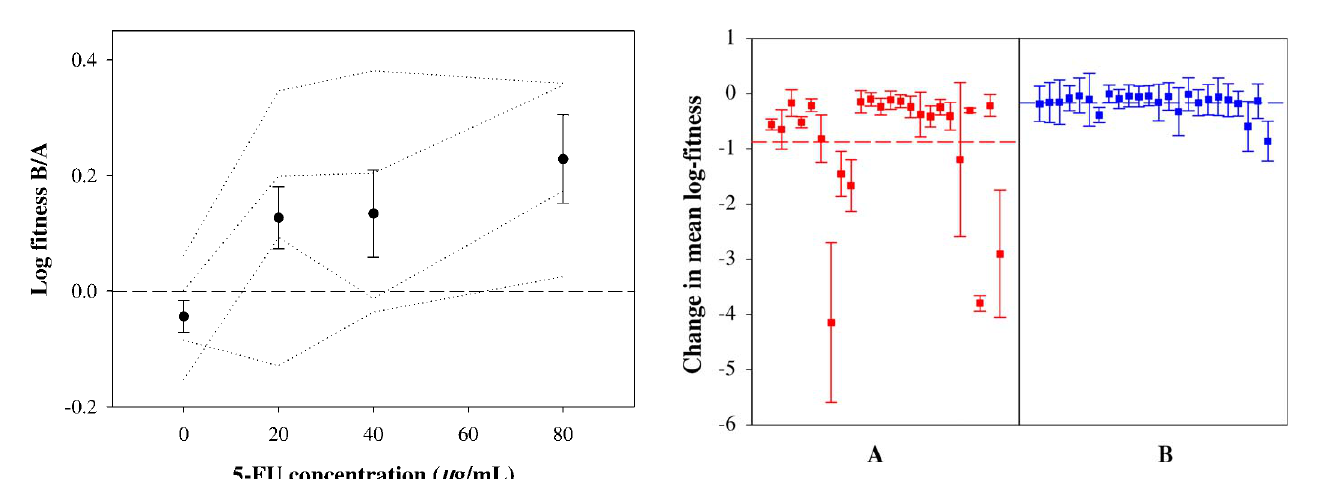
Figure 5. Change in Mean Log-Fitness in Mutation Accumulation Lines Derived from Populations A and B For A and B, each of the 24 lines is shown. Bars indicate 95% confidence intervals. Horizontal lines indicate the grand mean change in